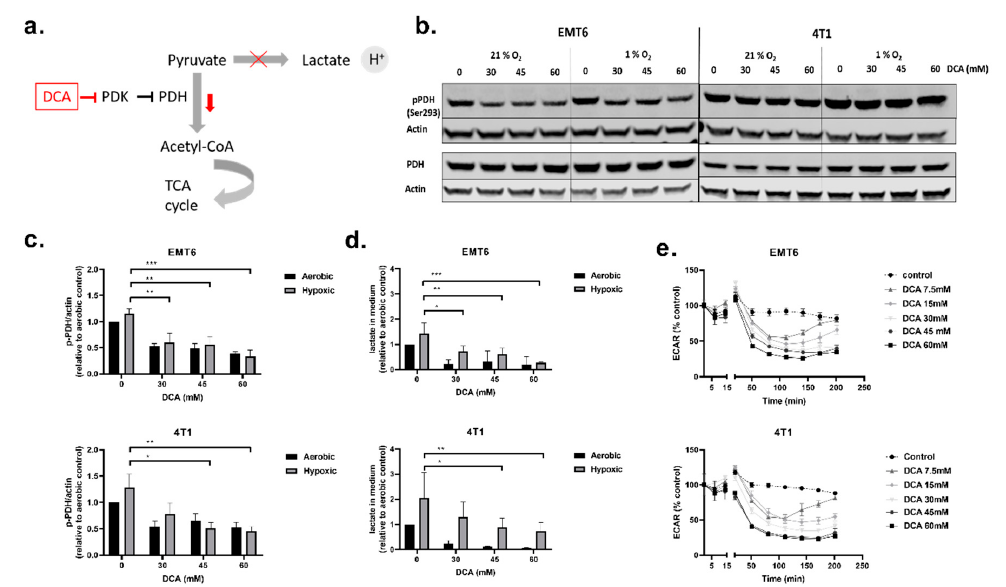
Figure 2. Dichloroacetate (DCA) decreases phosphorylated pyruvate dehydrogenase (PDH), lactate in the extracellular medium and ECAR of TNBC cells. ( a ) Schematic showing the influence of DCA